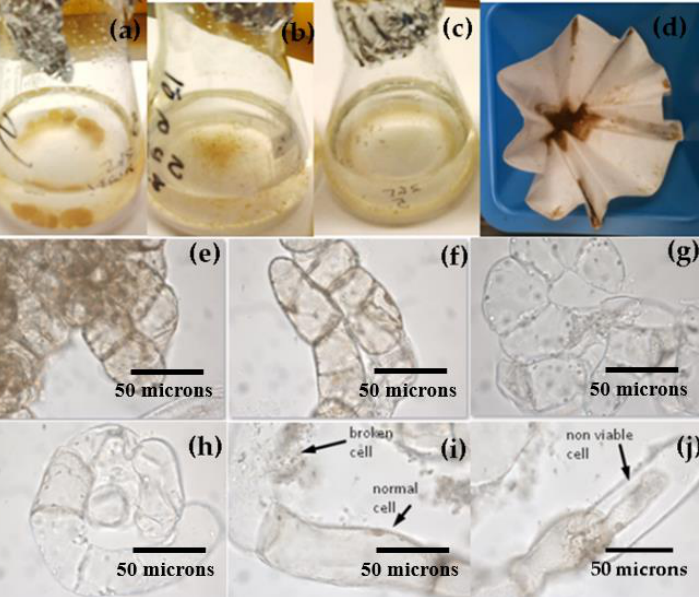
Figure 2. Suspension culture of T. officinale during the entire experimental period. T. officinale suspension culture. Suspension cultures at ( a , e ) 2nd week, ( b , f ) 4th week, and ( c , d , g , h ) 8th week, ( i ) Normal, broken cells, ( j ) non-viable cells. (Basal MS medium, 2.3% w / v sucrose, 3.0 mg/L NAA, 3.0 mg/L BAP, 0/24h light/dark, 20 ± 2 °C, 115 rpm, at 16th week of culture). Bars = 50 microns.